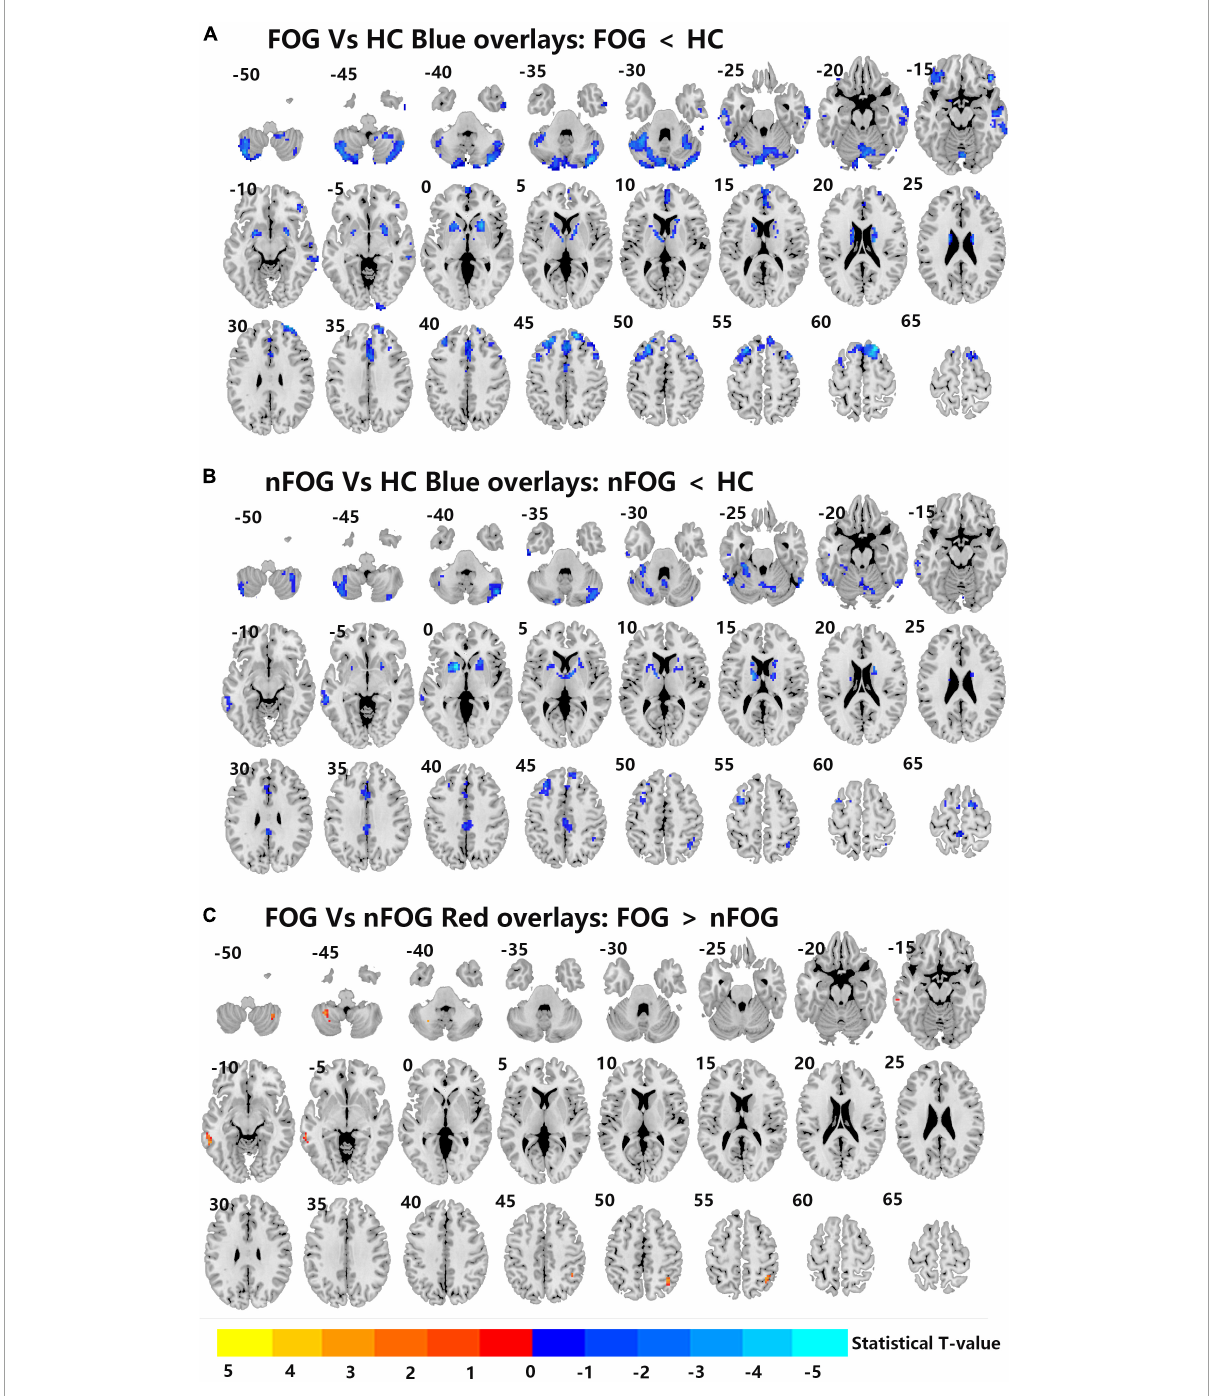
FIGURE3 (A–C) Differences in left thalamus dominated FC among MSA-FOG, MSA-nFOG, and HCs using post hoc correction for two-sample t -test (FDR-corrected p = 0.05).